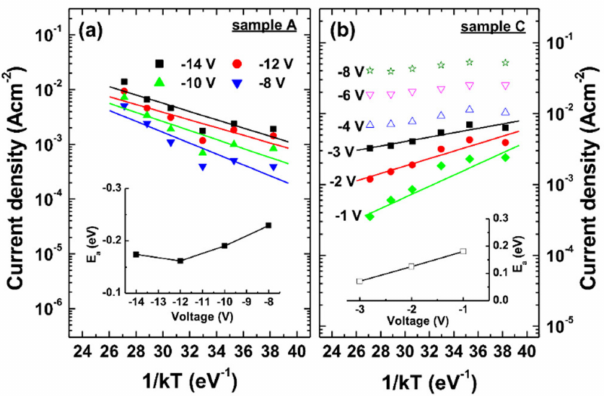
Figure 7. Reverse leakage current density vs. temperature at di ff erent reverse biases for samples ( a ) A and ( b ) C. The insets in ( a ) and ( b ) show the obtained activation energies for samples A and C,